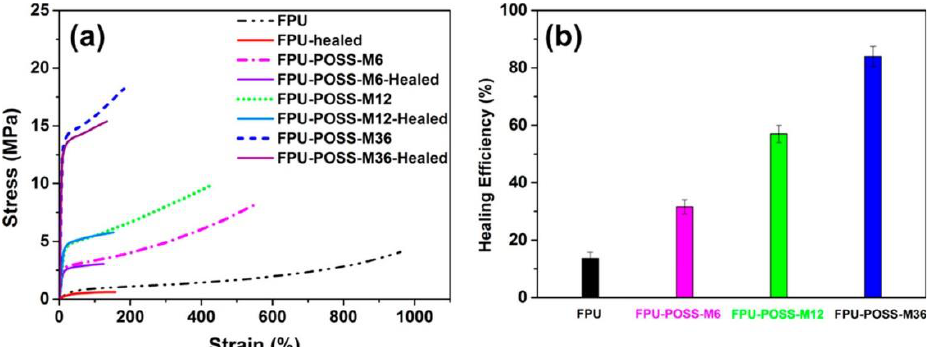
Figure 14. Stress−strain curves ( a ) and healing efficiency ( b ) of the native and self-repaired samples of FPU, FPU-POSS-M6, FPU-POSS-M12, and FPU-POSS-M36. Reprinted with permission from Mac- of FPU, FPU-POSS-M6, FPU-POSS-M12, and FPU-POSS-M36. Reprinted with permission